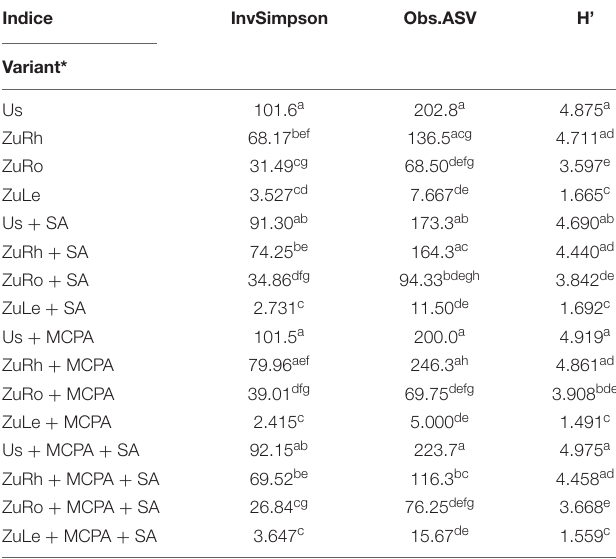
TABLE 3 | Alpha-diversity analyses: three alpha-diversity indices [viz. InvSimpson: inverse of Simpson’s diversity index; obs.ASV: the observed amount of operational taxonomic units (ASV); H’–Shannon’s diversity